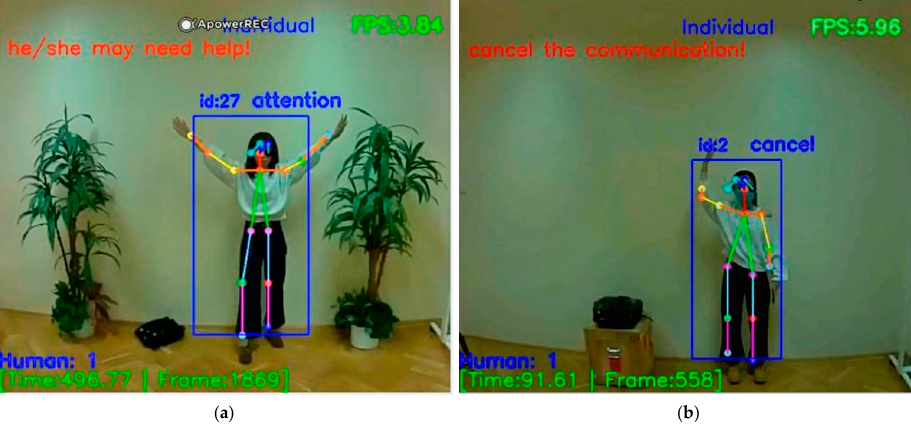
Figure 11. Attention gesture recognition ( a ) and Cancel gesture recognition ( b ). Sensors 2021 , 21 , x FOR PEER REVIEW